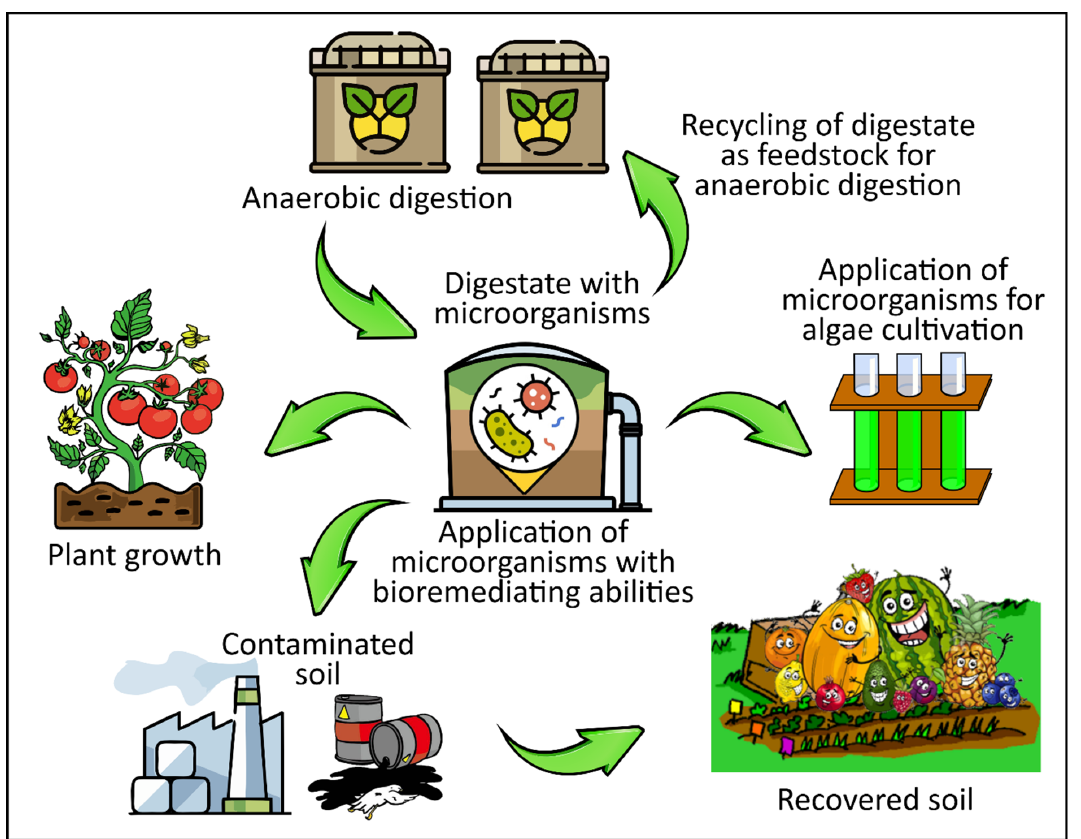
Figure 3. Different applications of digestate.